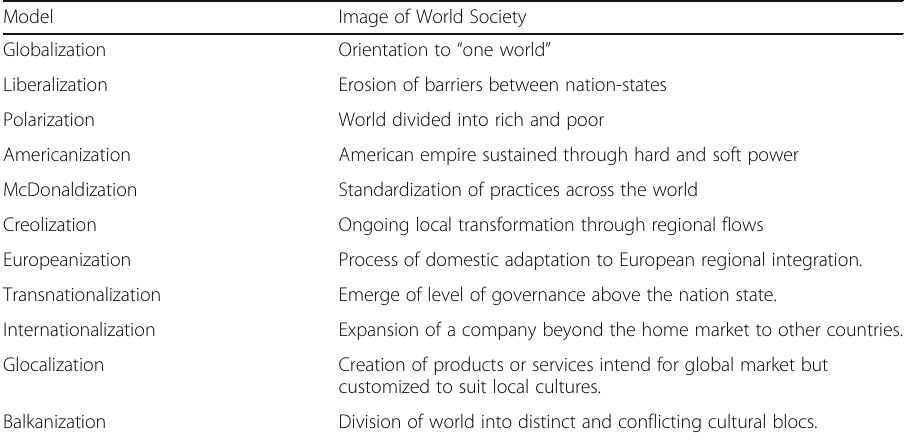
Table 1 Models of Global Change (Source: based on Bond and O'Byrne, 2014; Graziano & Vink, 2013; Craig et al., 2008; Khondker, 2004; Ritzer, 1983) Model Image of World Society Globalization Orientation to “ one world ” Liberalization Erosion of barriers between nation-states Polarization World divided into rich and poor Americanization American empire sustained through hard and soft power McDonaldization Standardization of practices across the world Creolization Ongoing local transformation through regional flows Europeanization Process of domestic adaptation to European regional integration. Transnationalization Emerge of level of governance above the nation state. Internationalization Expansion of a company beyond the home market to other countries. Glocalization Creation of products or services intend for global market but customized to suit local cultures. Balkanization Division of world into distinct and conflicting cultural